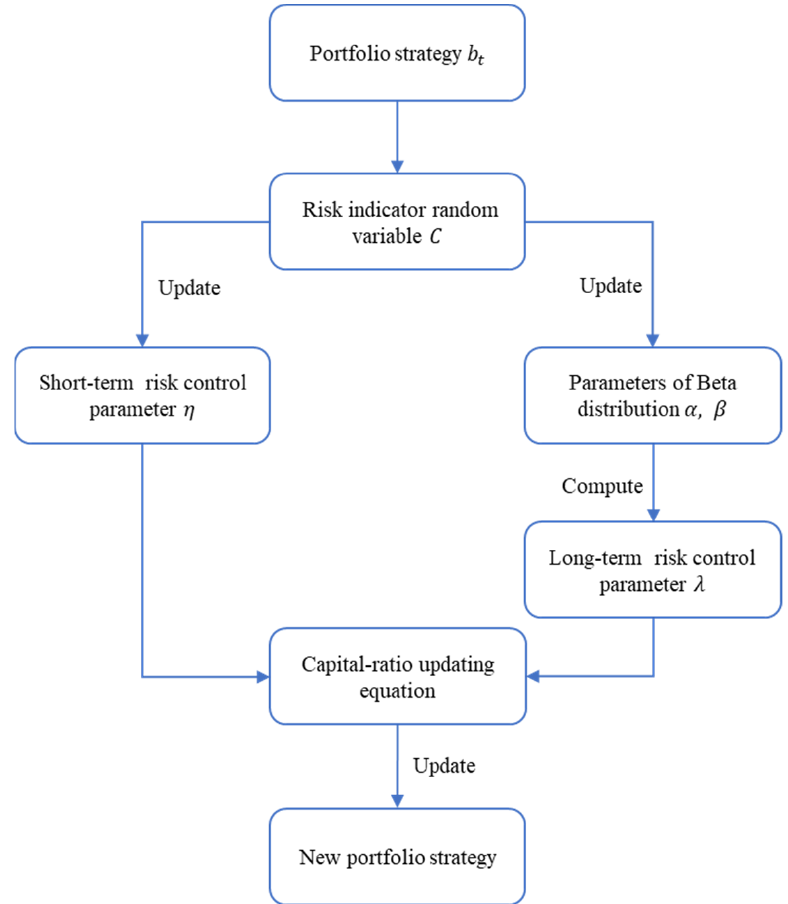
Figure 4. LSTR algorithm flowchart.